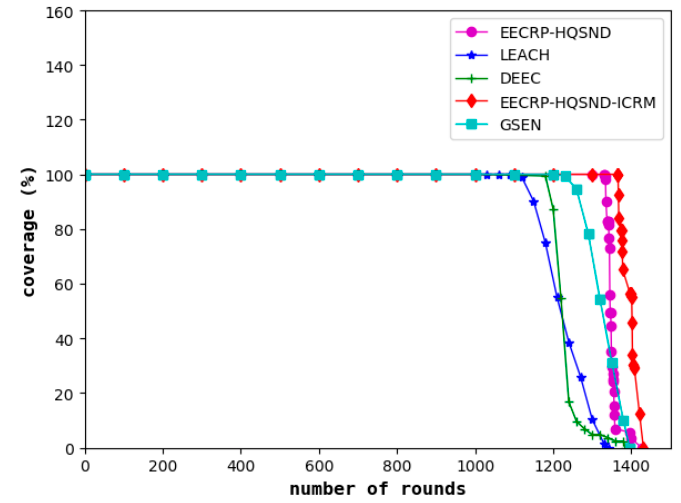
Figure 16. The network coverage varies with the iteration round.